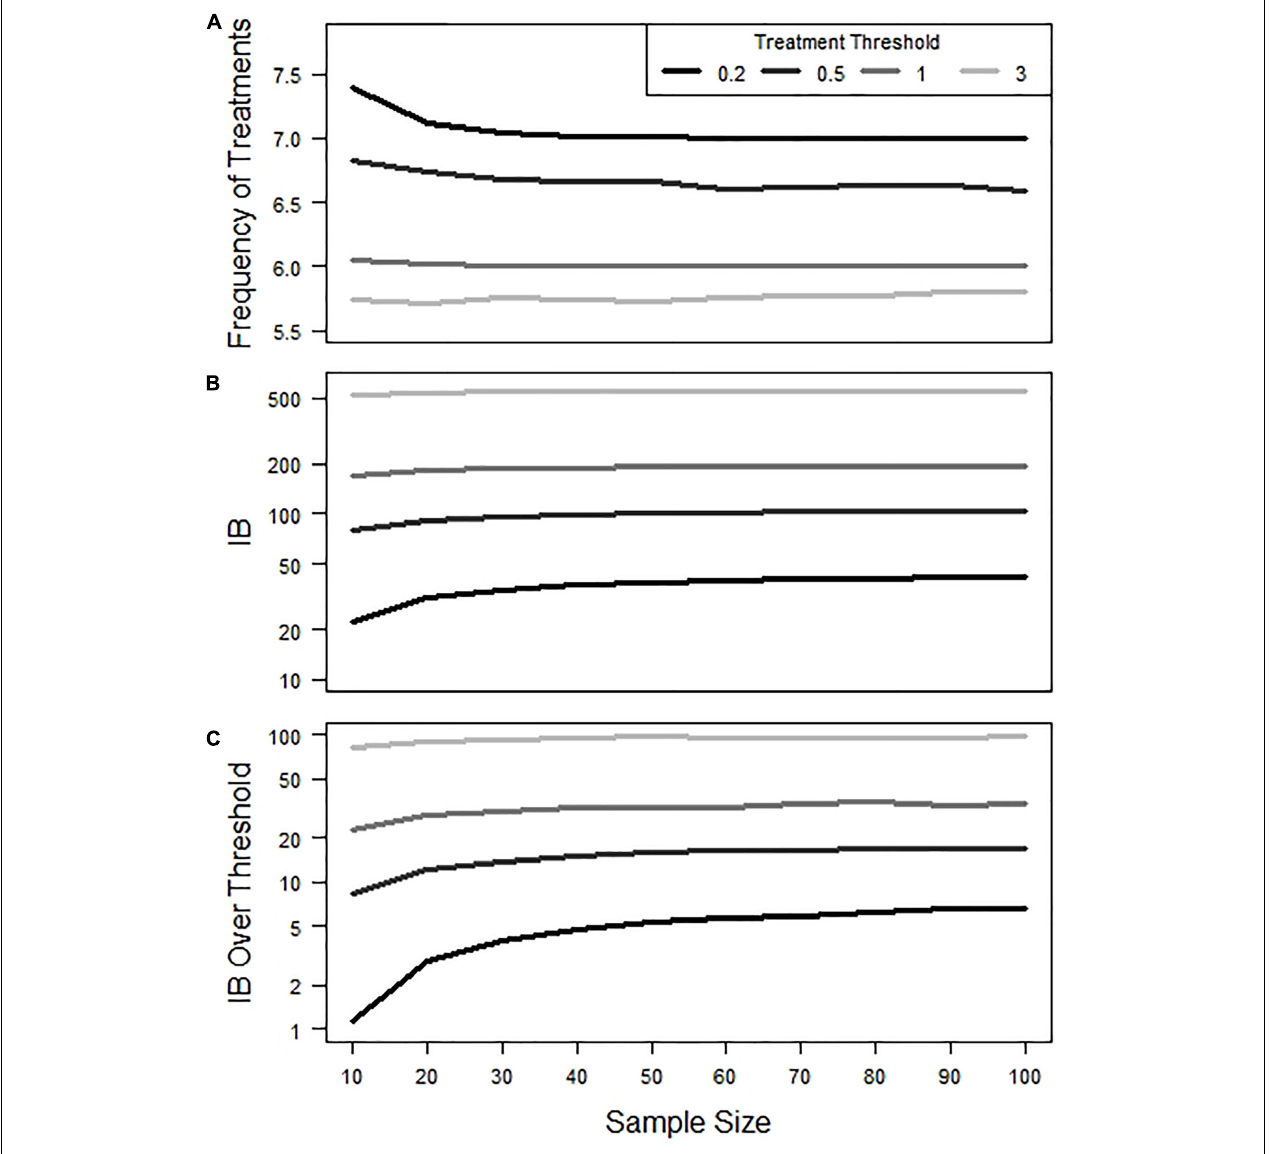
FIGURE 4 | Effect of sample size and treatment threshold on (A) frequency of total treatments, (B) Infestation Burden (IB), and (C) IB over Threshold during a production cycle. Y-axis in panels (B,C) are shown on a log